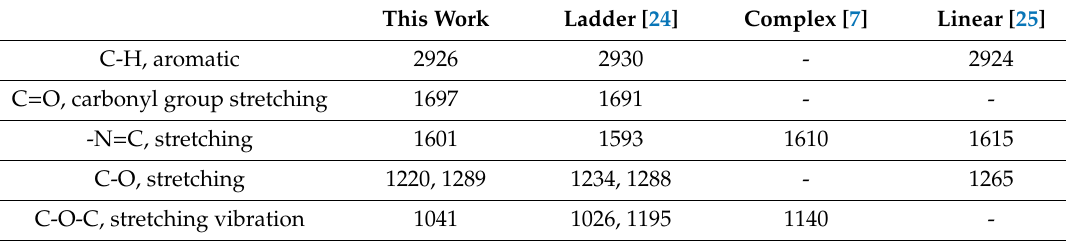
Figure 7. FTIR spectrum of mAP before ( left ) and after ( right ) plasma treatment. Table 2. IR peaks (unit cm − 1 ) of PmAP in literature and our present work.